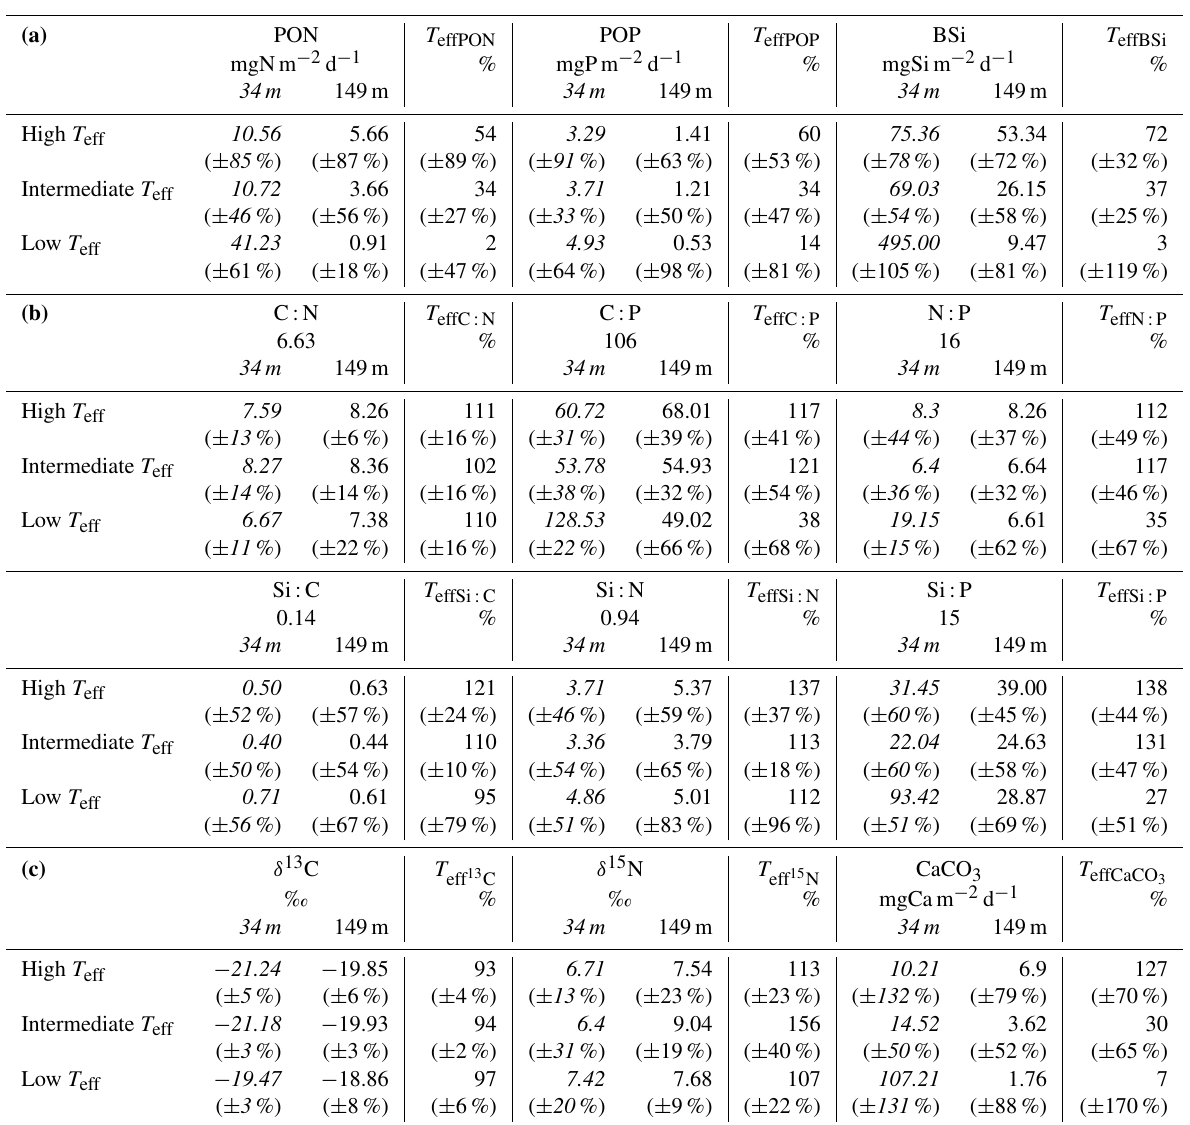
Table 3. Organic elemental fluxes and the corresponding molar ratios as well as inorganic and isotopic fluxes, and their transfer efficiencies for each main T eff range. (a) Organic elementary fluxes in mgm − 2 d − 1 and their transfer efficiency as a percentage ( T eff , T effPON , T effPOP , T effBSi ; see Table 1 caption for calculation) in terms of particulate organic carbon (POC), nitrogen (PON), phosphorus (POP) and biogenic silica (BSi) for each three main T eff ranges (low in red, intermediate in yellow, high in blue) with the temporal standard deviation among samples ( ± SD%). Italic and non-italic values correspond to the fluxes at 34 and 149m, respectively. Analysis accuracies on the elementary fluxes are ± 0 . 2% for both POC and PON, ± 3% for POP, and ± 5% for BSi, inducing an absolute uncertainty of ± 0 . 2% ( T eff ), ± 0 . 2% Si:C, Si:N, Si:P) and transfer efficiency of these ratios as a percentage ( T effC:N , T effC:P , T effN:P , T effSi:N , T effSi:N , T effSi:P ; see Table